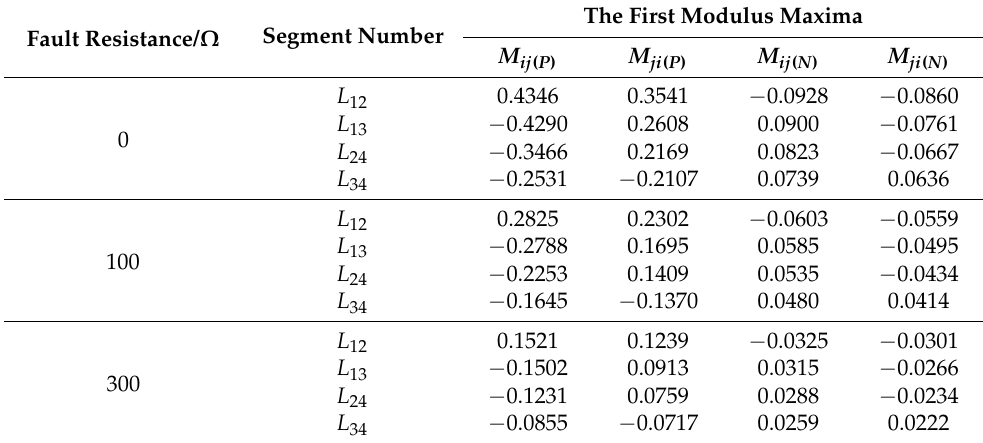
Table 5. Simulation results of WT modulus maxima with different fault resistances.